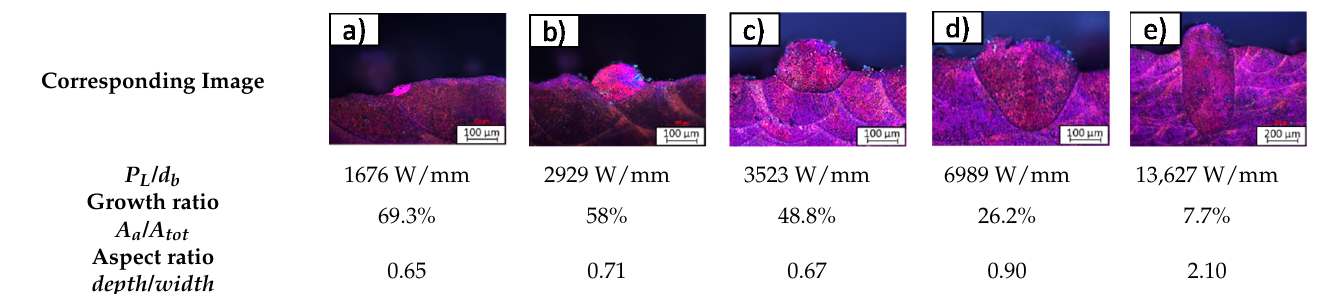
69.3% 69.3% 58% 48.8% 26.2% 7.7% 0.65 0.65